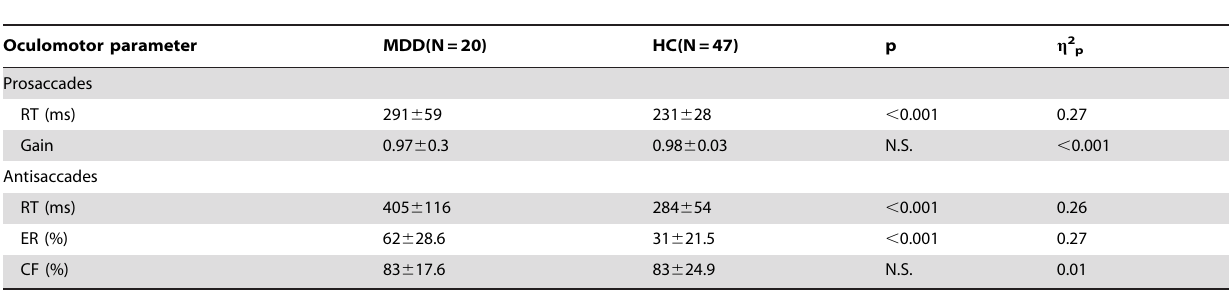
Table 2. Means and standard deviations for the saccadic reaction time, gain, error and correction